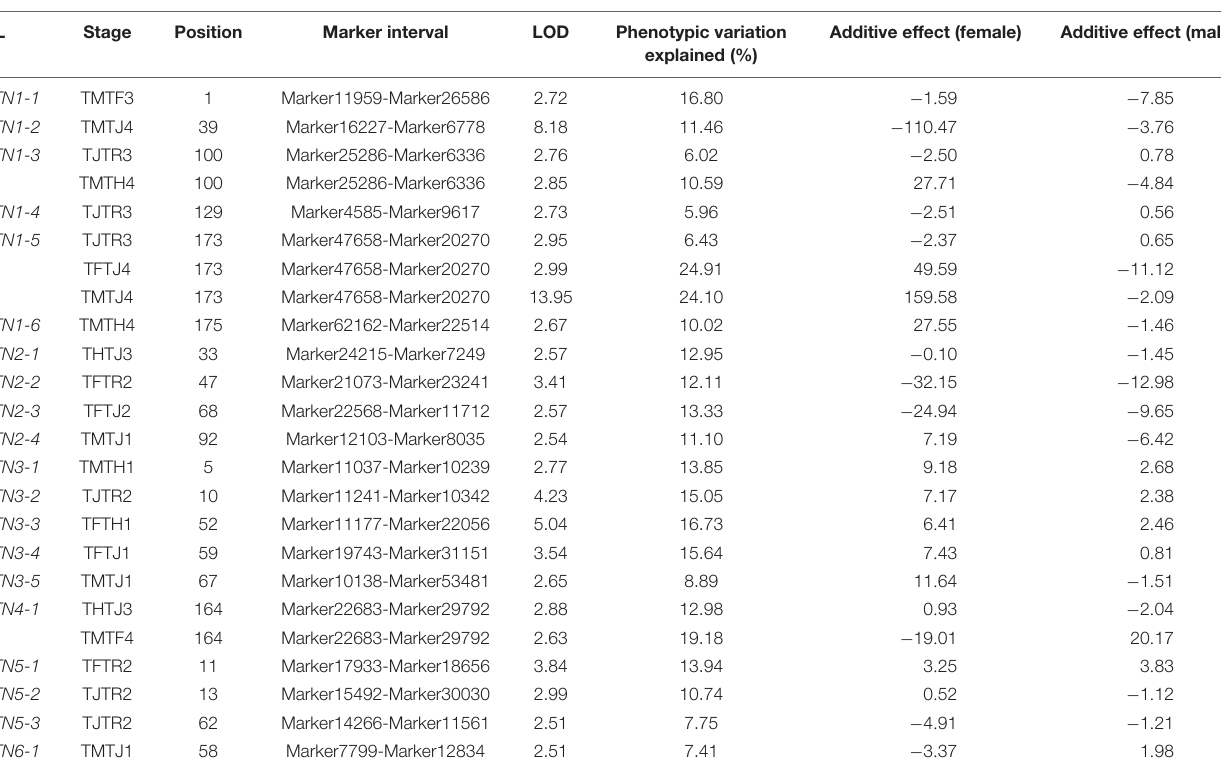
FIGURE 3 | Dynamic QTL changes in different stages and years. (A) For conditional QTL; (B) for unconditional QTL; RS, JS, HS, FS, and MS for recovering stage, jointing stage, heading stage, flowering stage, and maturity stage, respectively; the numbers in the box: 1 for 2017, 2 for 2018, 3 for 2020, and 4 for 2021. TABLE 3 | Conditional QTL positioning of TN at different stages in A.